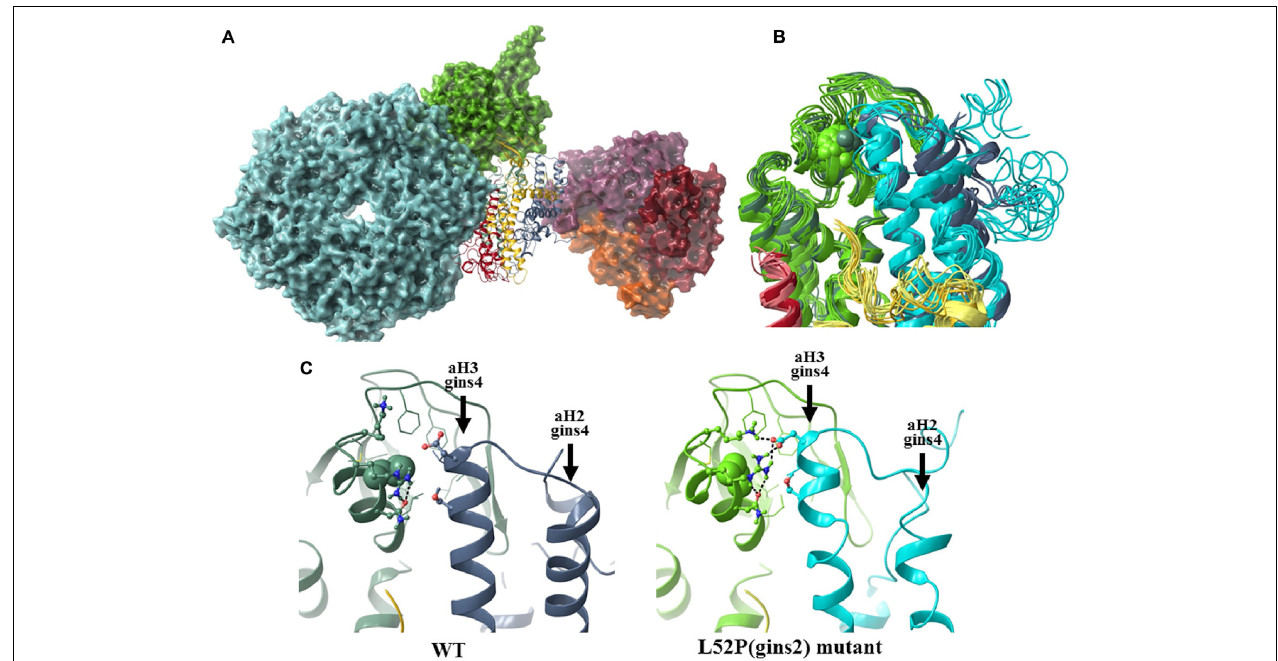
FIGURE 6 | The structural consequences of the Gins2 L52P mutation in the zebrafish GINS complex. (A) In silico generated model of the MCM-Cdc45-GINS-Ctf4 complex built using structures 3jc5 (Yuan et al., 2016), 4c8h (Simon et al., 2014), and the homology model of the zebrafish GINS complex created in this study. The MCM hexamer (cyan), Cdc45 (green), and the Ctf14 homotrimer (purple, red, and orange) are shown as surfaces, while GINS as a ribbon diagram (Gins1: yellow, Gins2: green, Gins3: red, Gins4: blue). (B) Superposition of the most populated cluster mid-structures (accounting for > 90% of all structures of the equilibrium trajectory). Coloring of the Gins monomers is the same as before, darker shades are used for the wildtype, the lighter for the mutant structures (residue 52 of Gins2 shown in space-filling representation). (C) Detailed view of the site of the mutation, with a typical H-bonding motif also